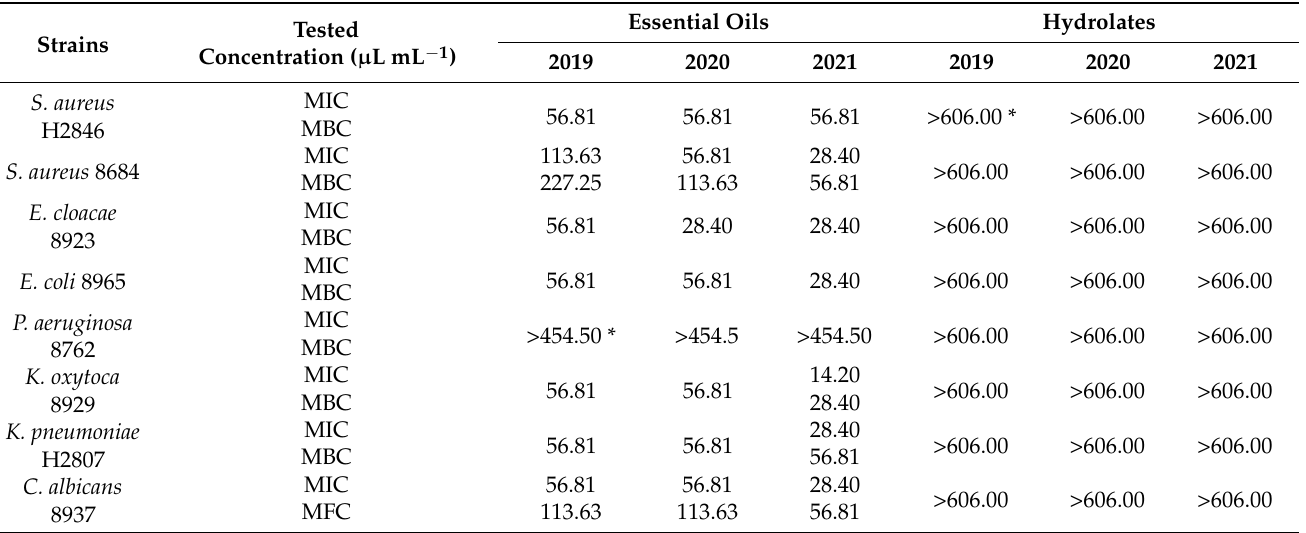
Table 8. Minimal inhibitory concentration (MIC) and minimal bactericidal/fungicidal concentration (MBC/MFC) for S. officinalis essential oil and